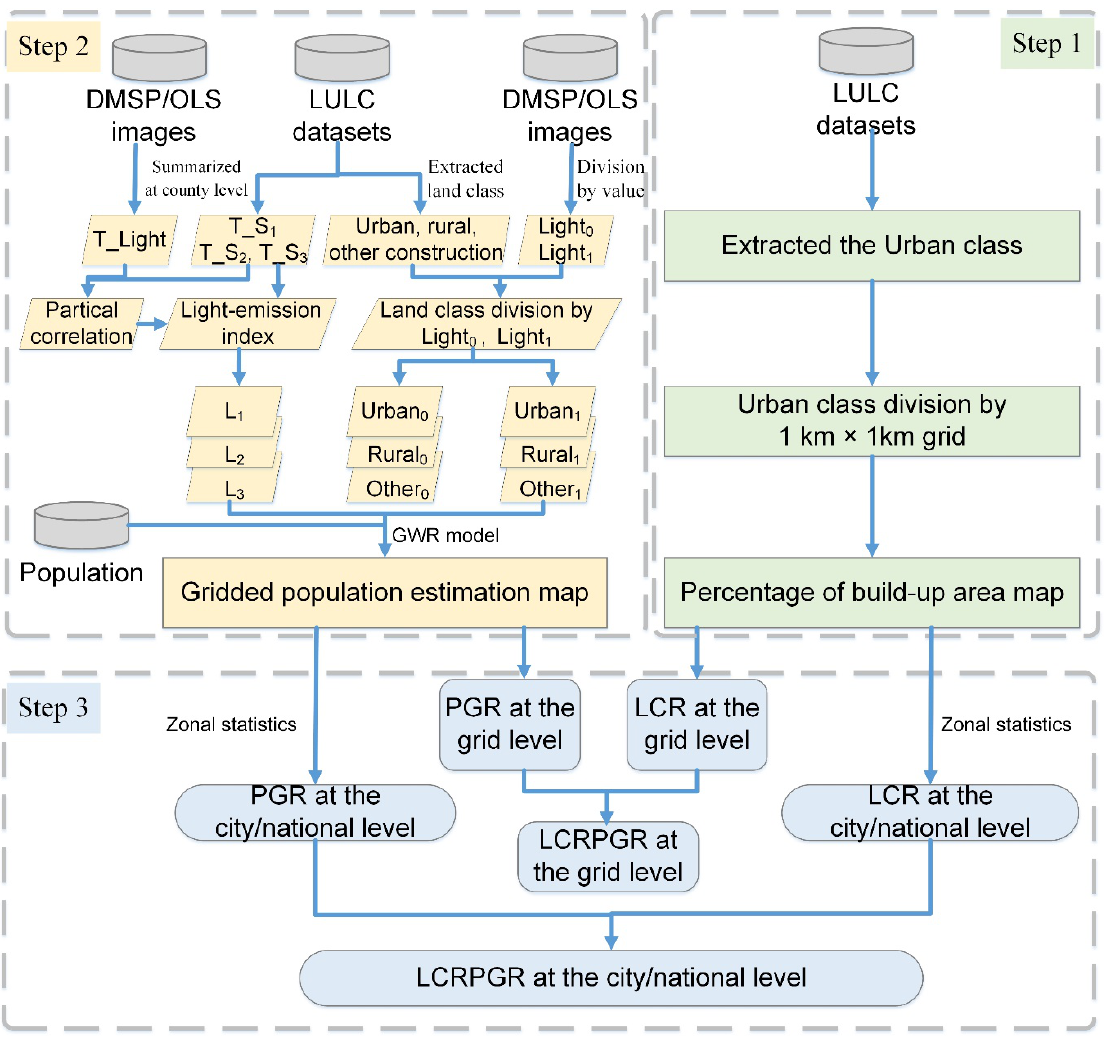
Figure 1. The flowchart of calculating SDG 11.3.1 (SDG: sustainable development goals; LCRPGR: The ratio of land consumption rate to population growth rate; LCR: land consumption rate; PGR: population growth